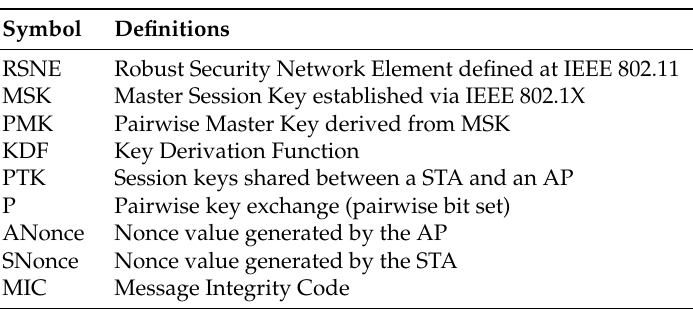
Figure 2. Sequence Diagram of the New Node Attachment in IEEE 802.11 with IEEE 802.1X. Table 1. Notations for the Figure